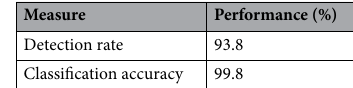
Table 1. Edge-TPU event detection